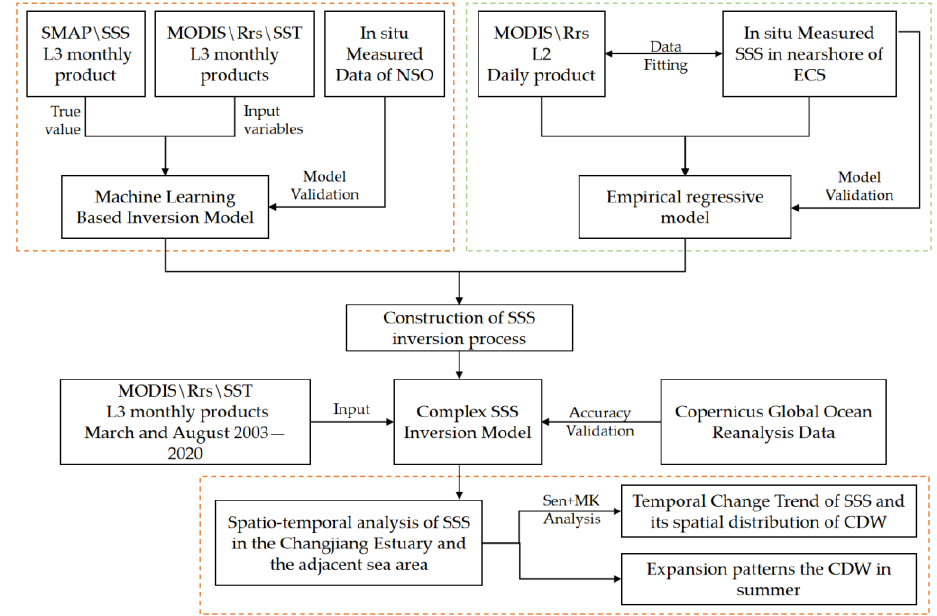
Figure 2. The technology road mapping used in this study.